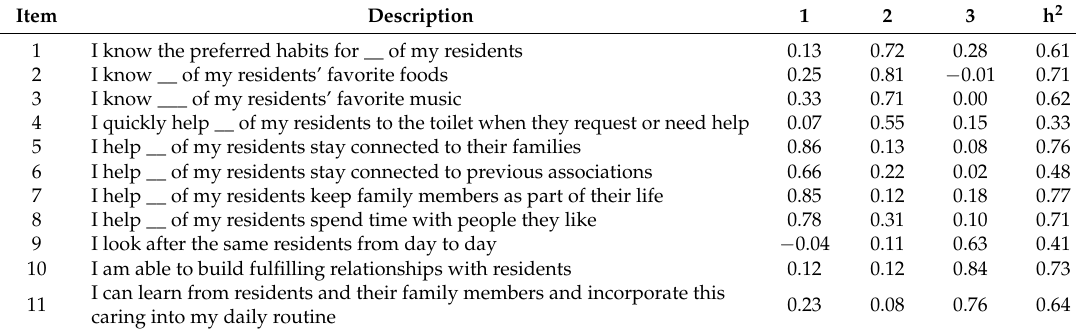
Table 4. Rotated Component Pattern and Final Communality Estimates from Principal Component Analysis of the TM-PCC